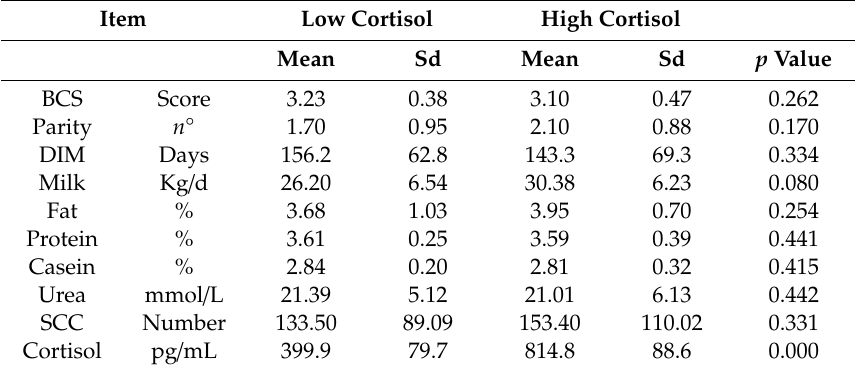
Table 1. Body condition score (BCS), parity, days in milking (DIM) and milk yield and quality in the 10 cows with lowest and 10 cows with highest cortisol concentration in